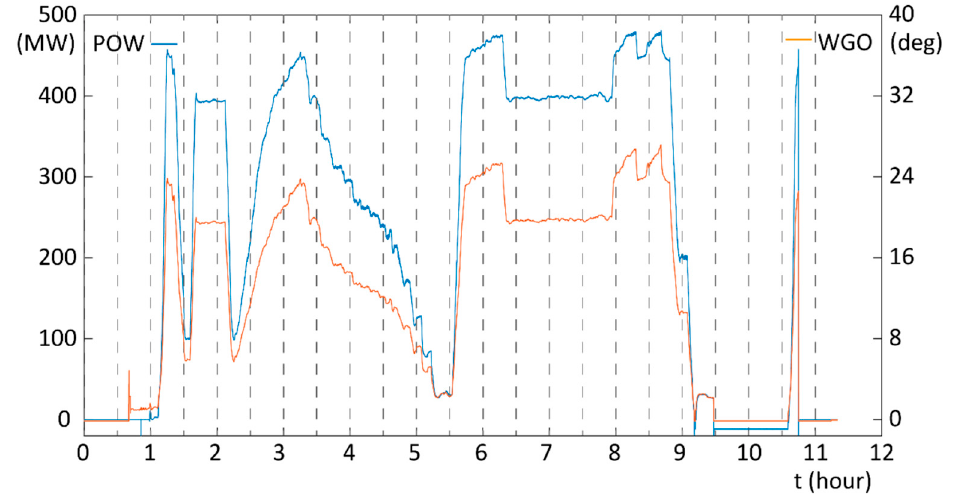
Figure 3. Testing procedure. Power of the machine (blue line) and Wicket Gate Opening (orange line) during the tests duration.